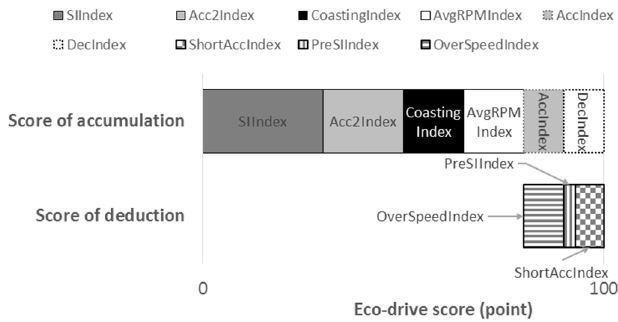
Figure 6. Schematic of eco-drive scoring distribution of each monitoring item.